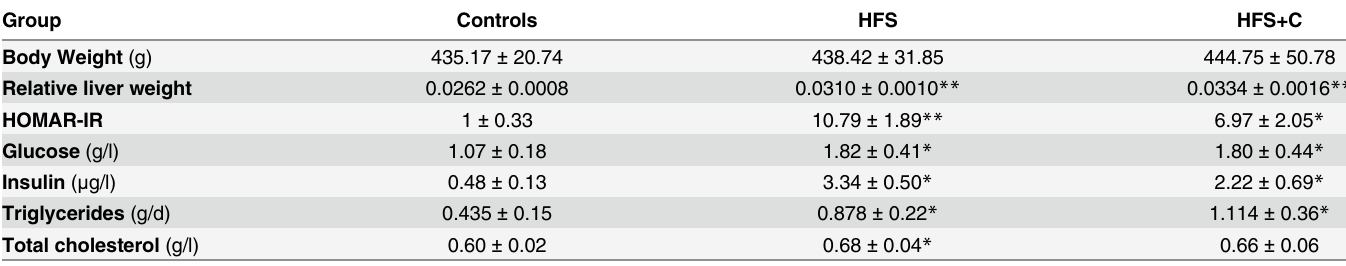
Table 2. Results of serum biochemical analysis after 10 weeks of diet.